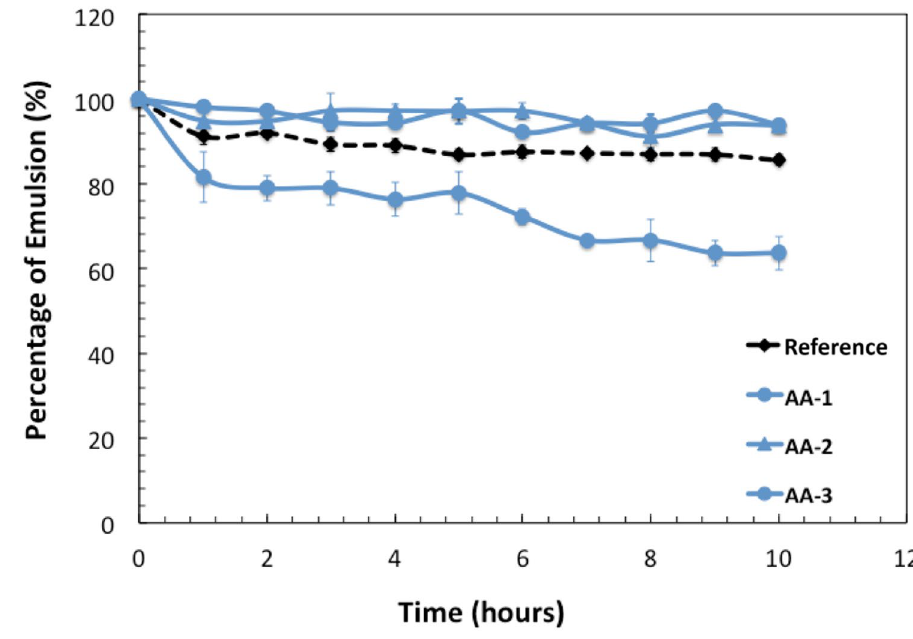
Fig. 5 Percentage of emulsion as a function of time for three AA emulsion systems (blue) and the reference (blank) emul- sion (black). Each data point and associated error bar represent the mean and standard deviation resulting from inde- pendent triplicate measurements